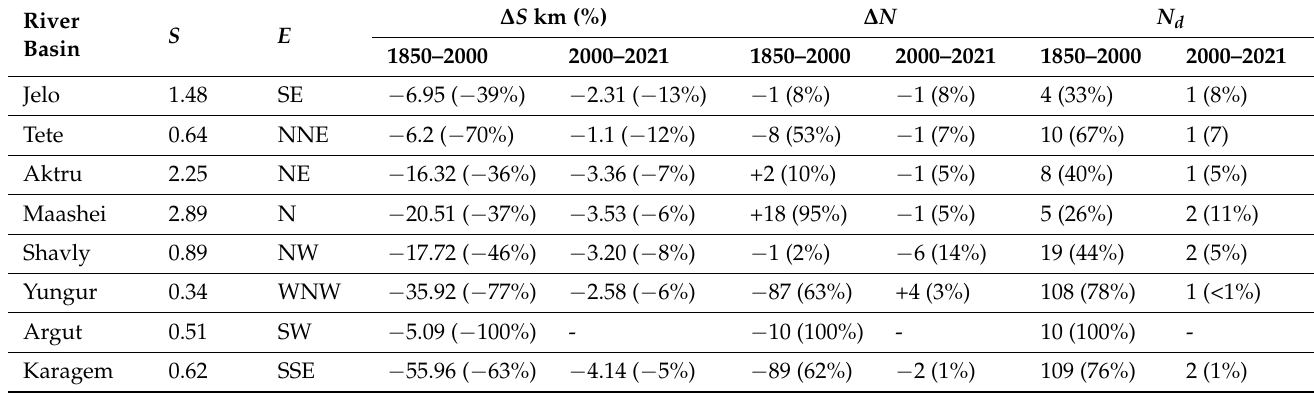
Table 8. Reduction of glaciers of the North-Chuya range from the maximum of the LIA to 2021 by river basins. ∆ S km (%): changes of the total glacier area, km (% to the LIA area); ∆ N: changes of the number of glaciers (% to the LIA); N d : the number of the glaciers that disappeared (% to the